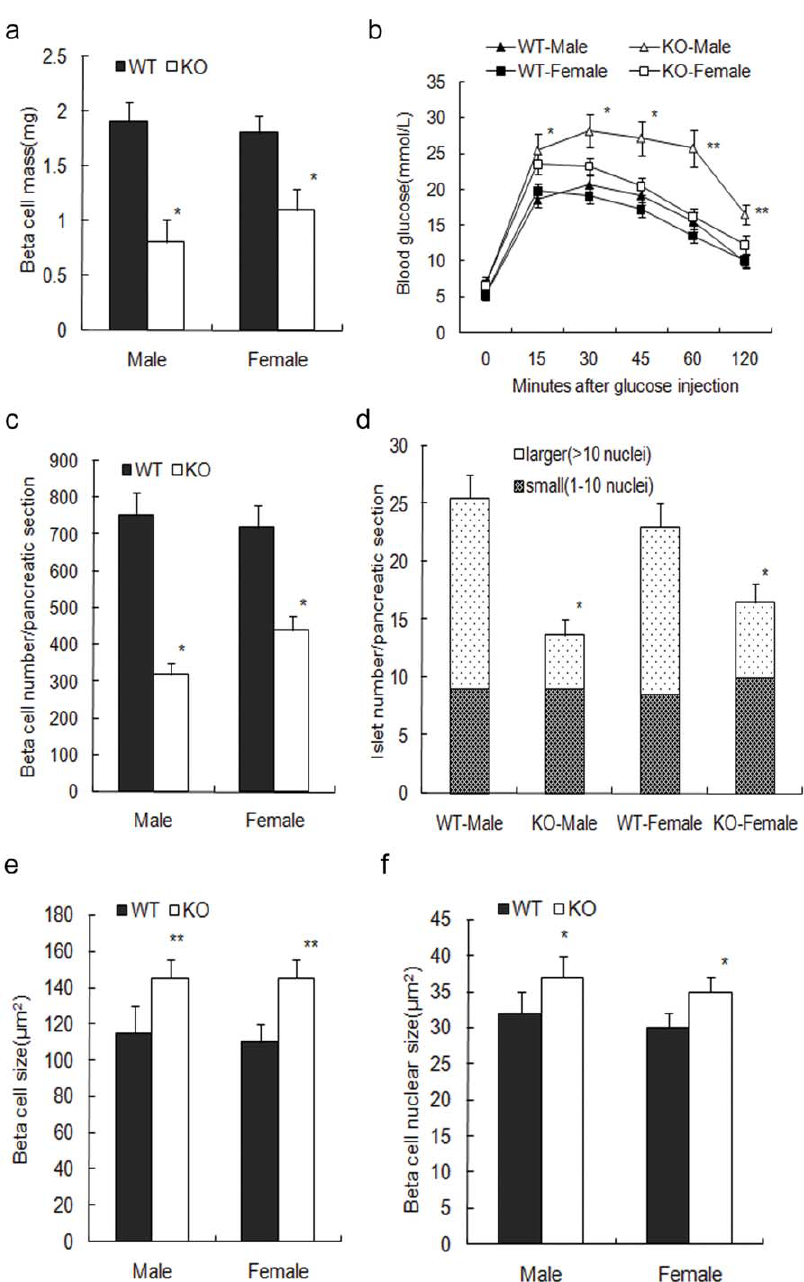
Figure 3. Survivin deletion in beta cells leads to decreased beta-cell mass. (a) Male and female mutant mice exhibit decreased beta-cell mass at 2-month of age as compared to controls (n=5 per genotype). (b) IPGTTs show that the male mutant mice ( g ) display higher glucose excursions compared with male controls ( m ) whereas the female mutant mice ( % ) show similar responses as female controls ( & ) (n=8 per genotype). (c) Declined beta-cell number is detected in the male and female mutant mice (n=5 per genotype). (d) Total islet number is decreased in the mutant mice compared with that in controls in both sexes, mainly due to the decreased definitive islets, with small islets remained similar (n=5 per genotype). (e) Increased beta-cell size is observed in the mutant mice in both sexes (n=5 per genotype). (f) Mutant mice exhibit increased beta-cell nucleus size in both sexes (n=5 per genotype). WT, wildtype (black bars); KO, knockout (white bars). The data represent as means 6 SE. *, p , 0.05;**, p , 0.01vs